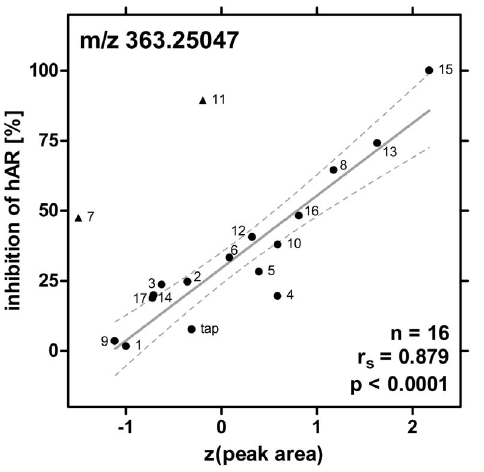
Figure 2. Correlation of the peak areas (Z-transform) of the final candidate (exact mass 363.25047) with the antiandro- genicity. Data from Orbitrap experiment 1 is shown here exemplarily. Triangles indicate outliers, the linear regression (with 95% confidence bands) is shown in grey.